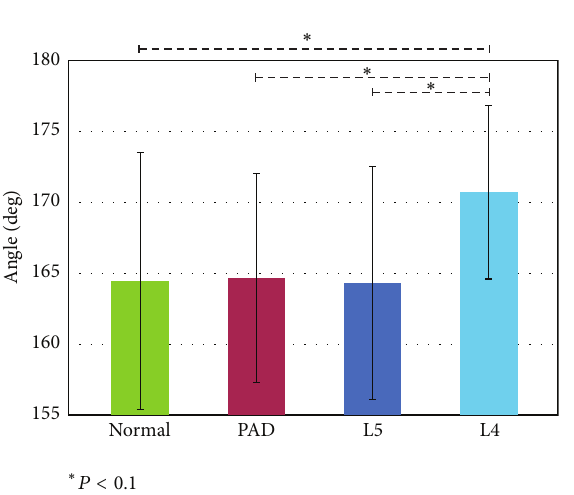
Table 1: Extracted features for differentiating among normal, PAD, L5 and L4, and which features are used in the presented SVM classifier- based methodology. The first row shows the target class for the binary classifier: for example, “normal” means the classifier for distinguishing the normal group from the other groups. “+” denotes the selected features and “ − ” the nonselected features for each classifier. Target group for classification Normal PAD L5 L4 Mean ankle angle + + + + Knee angle at the start of the stance phase − − − + Amplitude of the femur angle + − − − Maximally relaxed muscle length of the gastrocnemius muscle from the reference model − + + + Maximally contracted muscle length of the gastrocnemius muscle from the reference model + + + + Range of motion of the gastrocnemius muscle from the reference model + − − − Maximally relaxed muscle length of the quadriceps muscle from the reference model + − − − Maximally contracted muscle length of the quadriceps muscle from the reference model − − − + Range of motion of the quadriceps muscle from the reference model − +